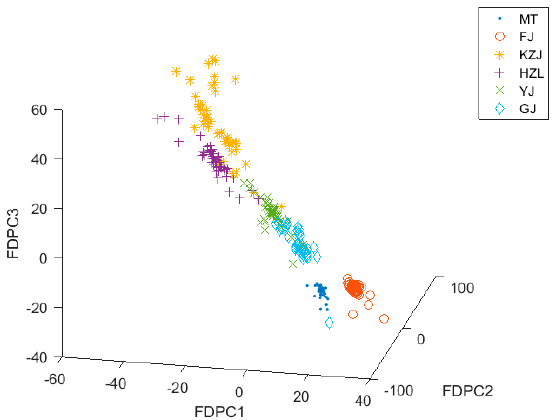
Figure 8. Three-dimensional distribution of data after fuzzy discriminant principal component analysis (FDPCA).